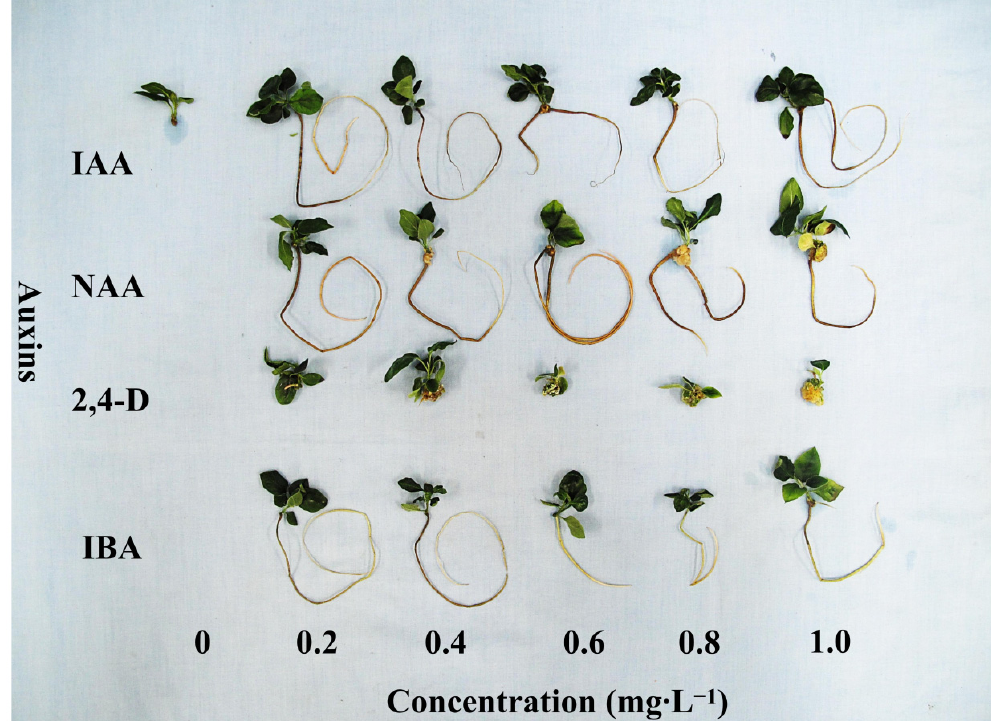
Figure 3. Root induced by different concentrations of auxins in Cotoneaster wilsonii .